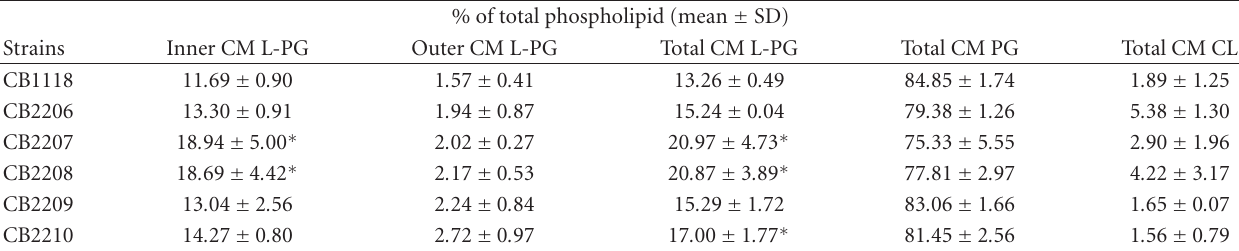
Table 3: Cell membrane (CM) phospholipid composition and asymmetry of L-PG.